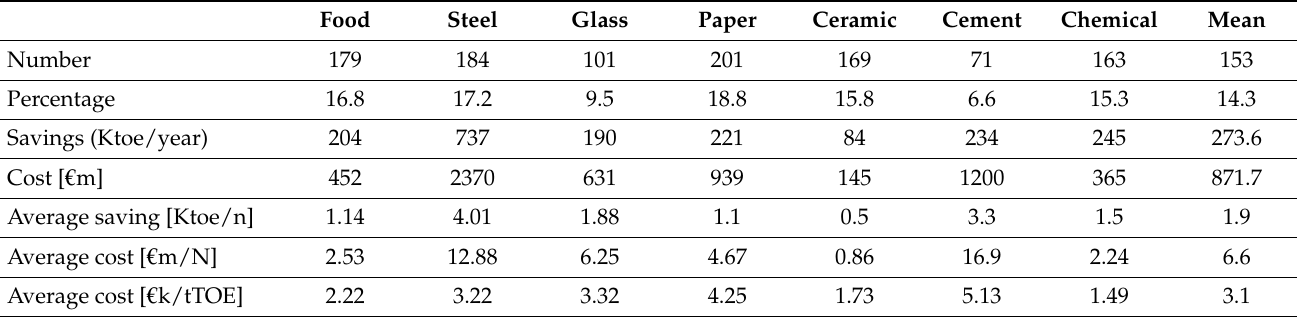
Table 3. Key insight from the survey on